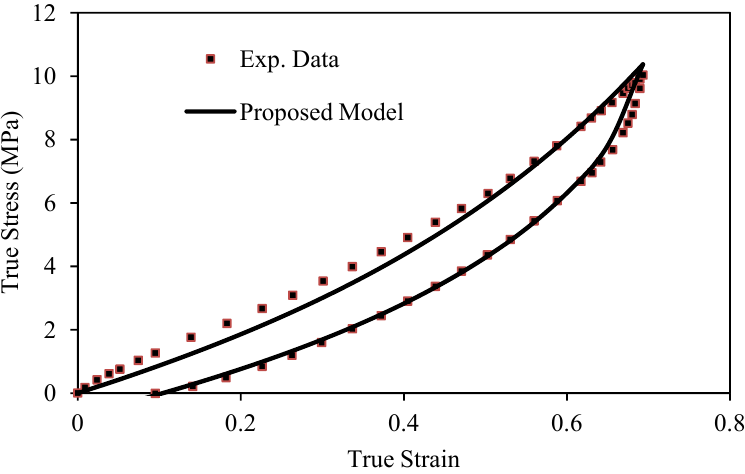
Figure 6. Comparison of theoretical predictions obtained from the proposed model given by Equation (25) with experimental data for 1 phr NR-SWCNT. Here the material parameter values are δ = 0.3 and C = 1.0 MPa. Experimental data adapted from